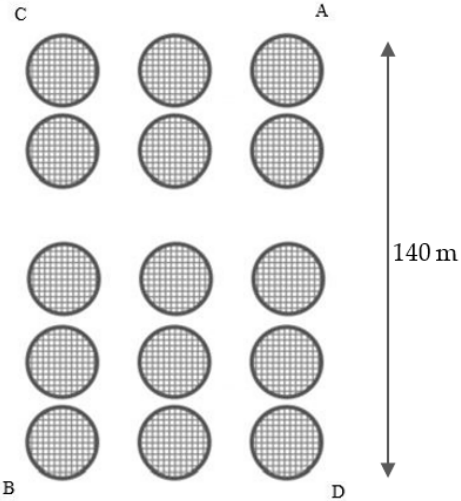
Figure 2. Layout of the system and location of the 4 preliminary sampling sites (A, B, C, D).